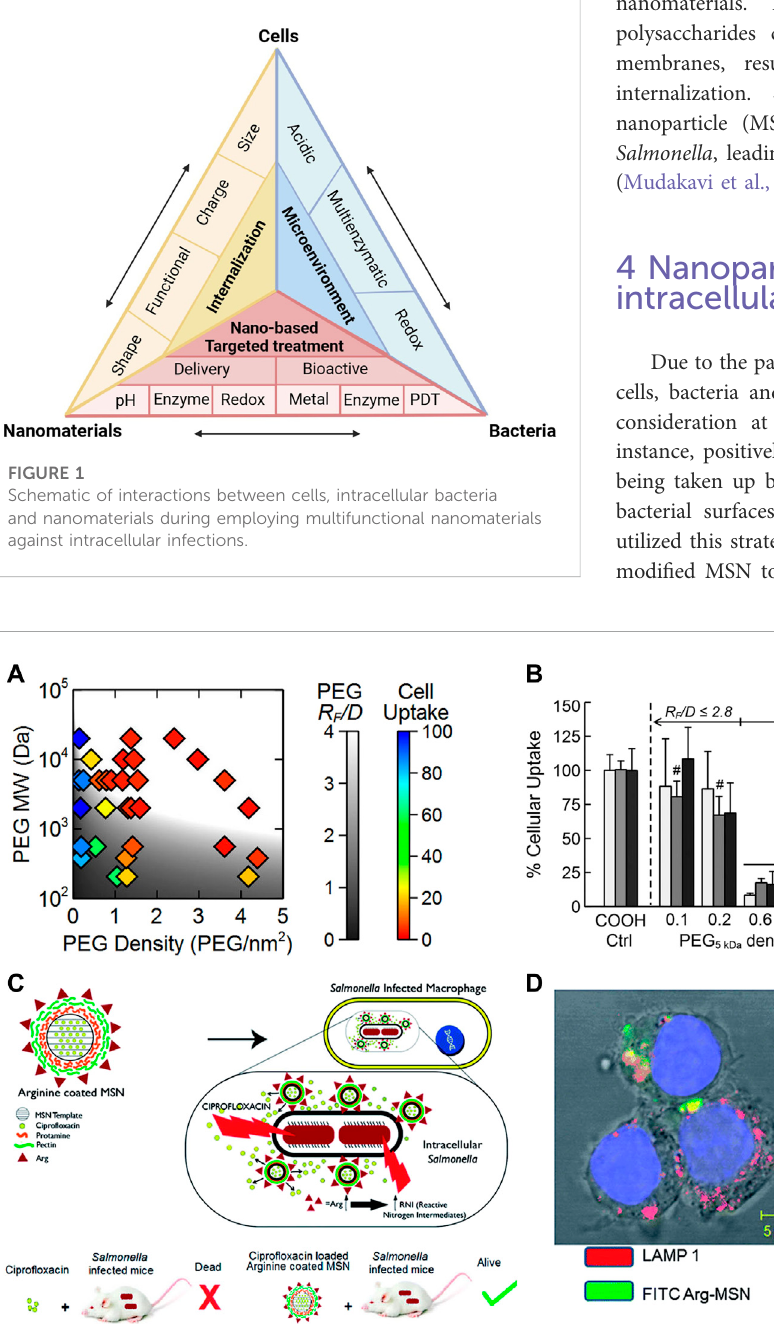
FIGURE 2 (A,B) Internalization probability of PEG functionalized nanoparticles with various grafting densities by differentiated human THP-1 cells. (C) Schematicillustrationofthesurfacearginine-modi fi edMSNco-localizedwithintracellular Salmonella ,resultinginef fi cientantibioticdelivery. (D) Cellular traf fi cking and mechanism of endocytosis of Arg-MSN in RAW 264.7 cells. (E) Cellular uptake of Arg-MSN particles in the presence of pharmacological inhibitors of endocytosis. Reproduced with permission from Yang et al. (2014) (Copyright 2014 American Chemical Society) and Mudakavi et al.